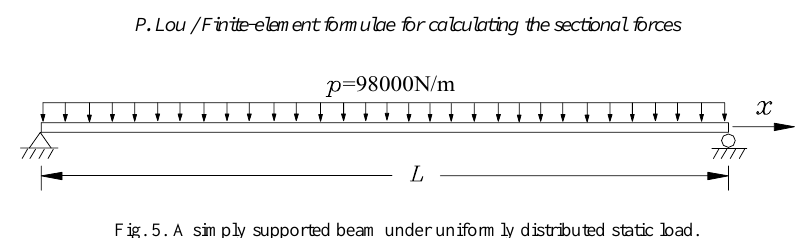
Fig. 5. A simply supported beam under uniformly distributed static